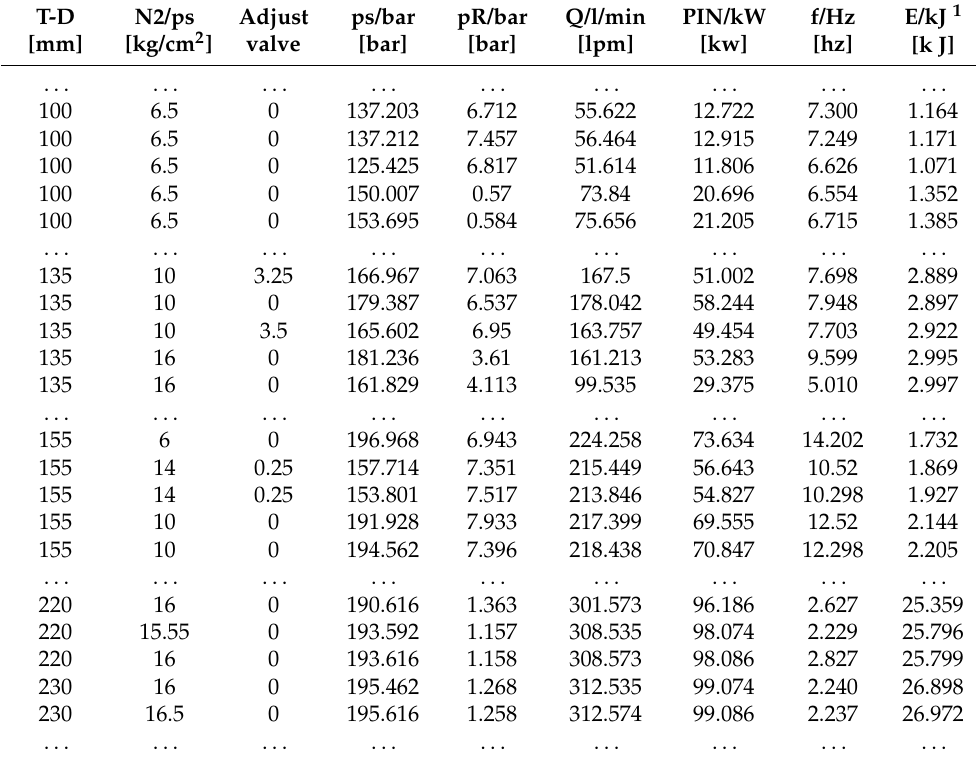
Table 1. Performance test data of large-class hydraulic